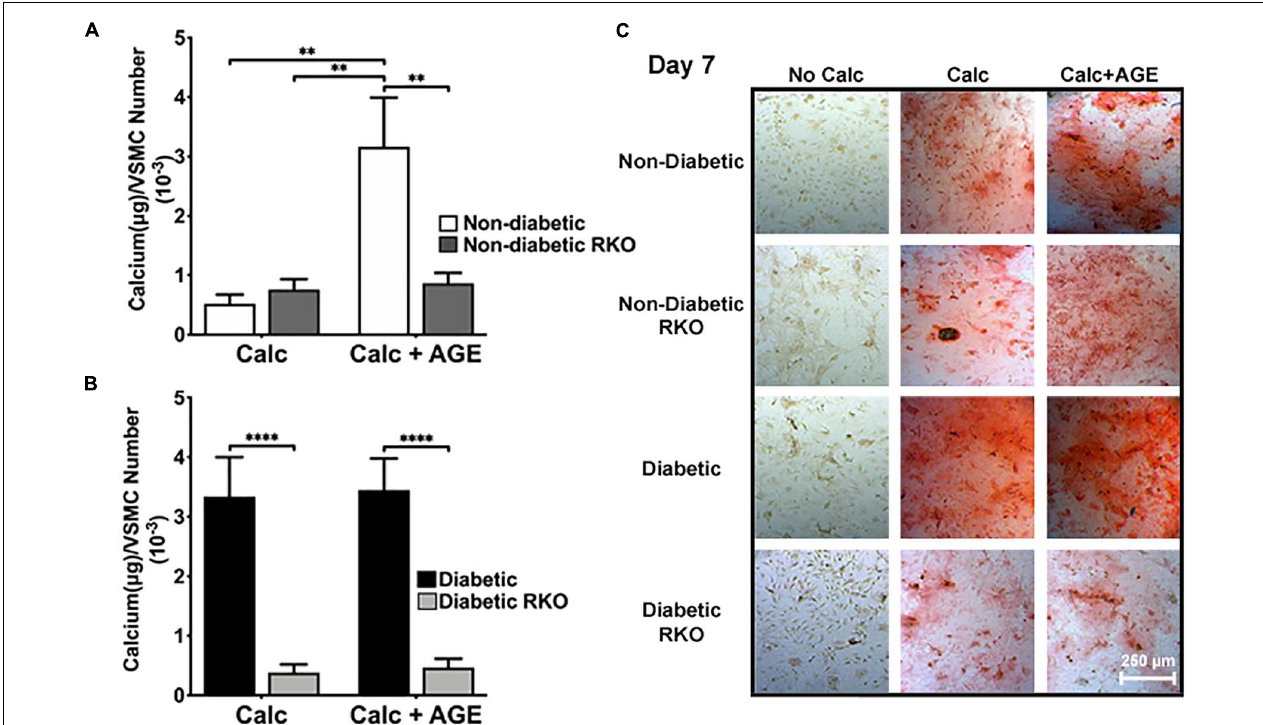
FIGURE 1 | Vascular Smooth Muscle Cell (VSMC) calcification is affected by the presence of AGE-mediated RAGE signaling. Primary mouse VSMCs were isolated from non-diabetic and diabetic aortas with or without the presence of RAGE. VSMCs were plated onto 96 well plates and treated with 3 mM P i with or without AGEs (0.5 mg/mL) for 7 days. (A,B) Calcium ( µ g) was normalized to cell number and graphed as mean ± SEM with n = 6–9 of independent replicates. (C) Alizarin red staining indicated calcification by the red staining. (4X and scale bar = 200 µ M) Statistical analysis consisted of a one-way ANOVA and a Fisher’s LSD test post hoc (** p < 0.05, **** p <